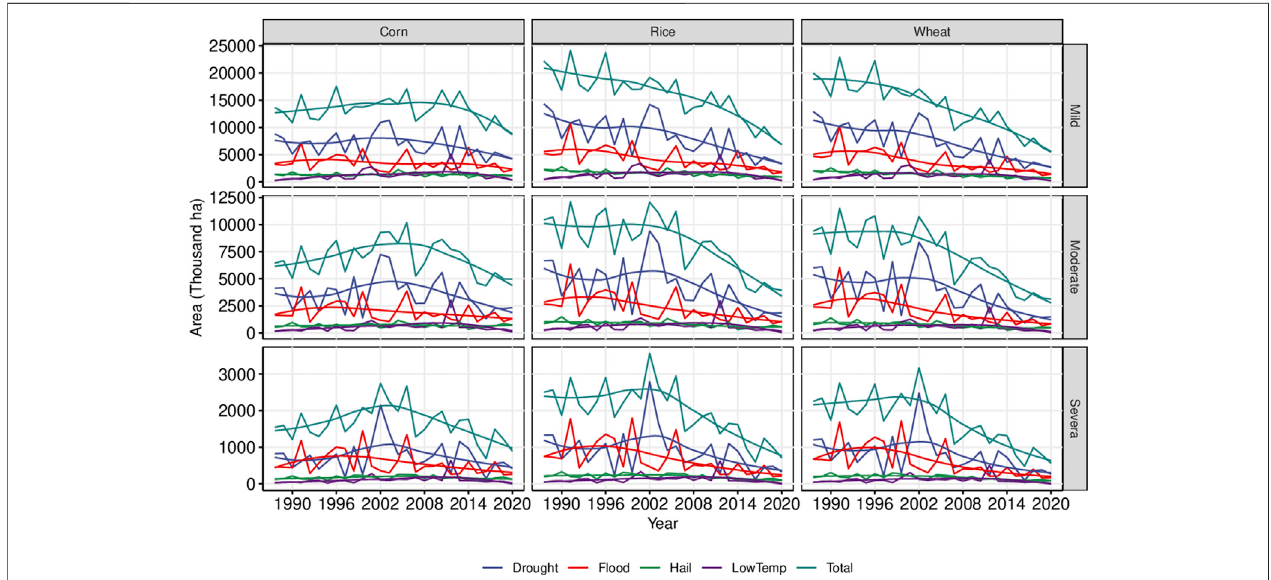
FIGURE 1 | Trends in the area affected by natural disasters from 1988 to 2020. The smooth lines in each panel represent loss trends.